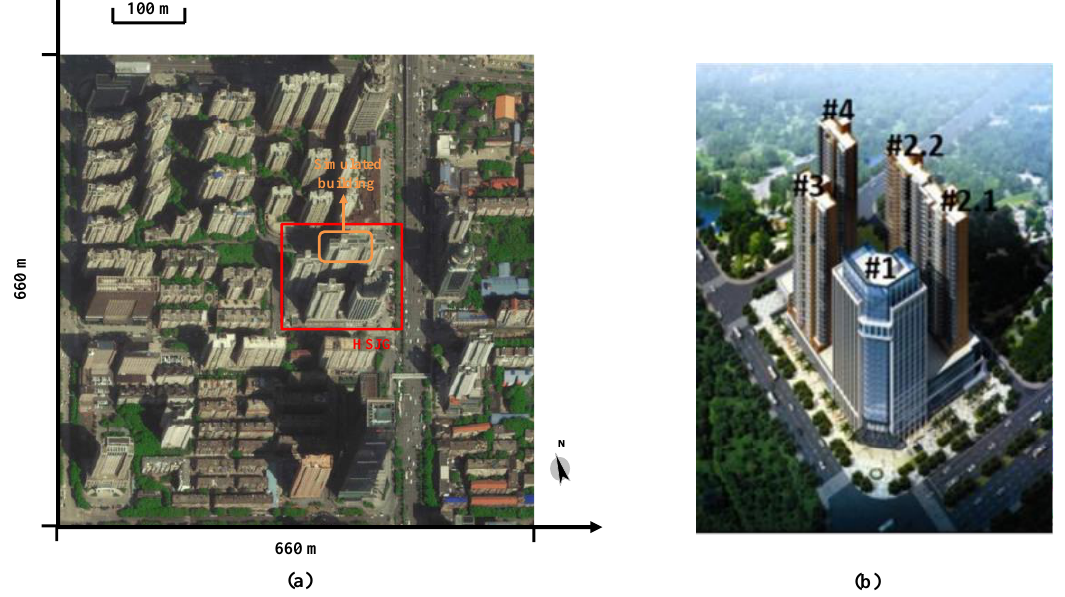
Figure 4. ( a ) Simulated area in ENVI-met and ( b ) HSJG block.